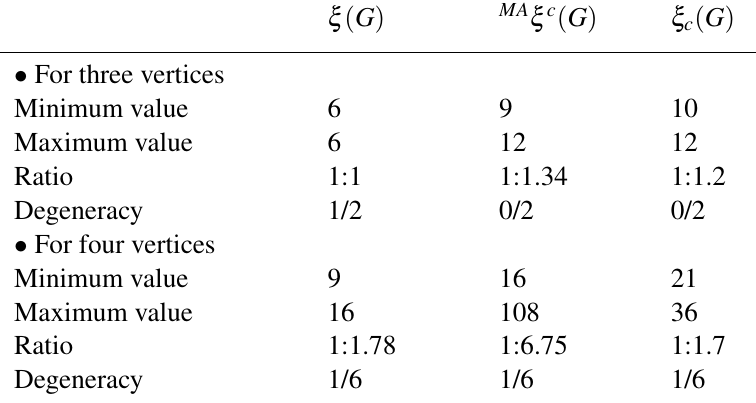
Table 6 Comparison of the discriminating power and degeneracy of eccentric connectivity index, modified eccentric connectivity index and modified augmented eccentric connectivity index using all possible structures with three and four vertices.